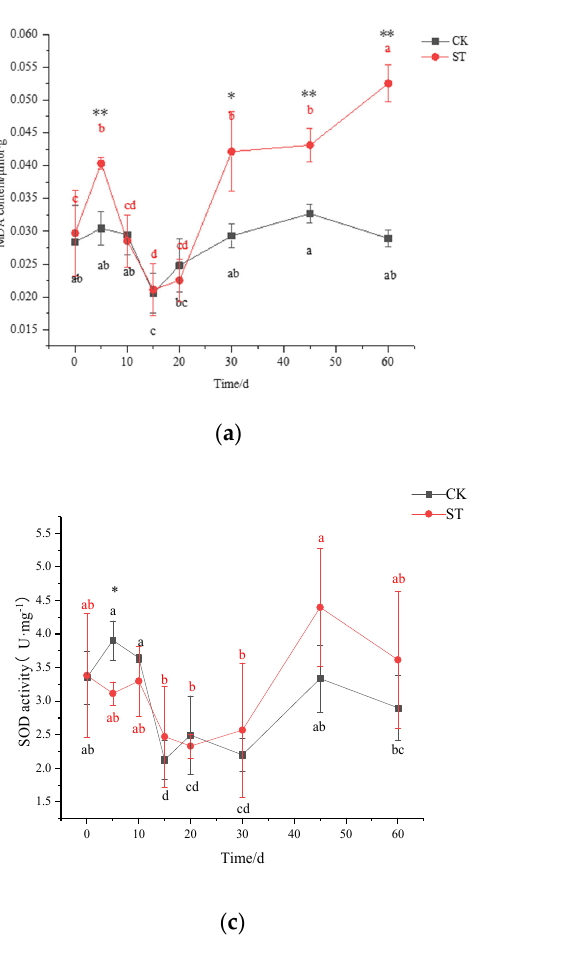
Table 3. Effects of salt stress on osmotic regulators in the seedlings of C. hongkongensis subsp. tonkinensi s.